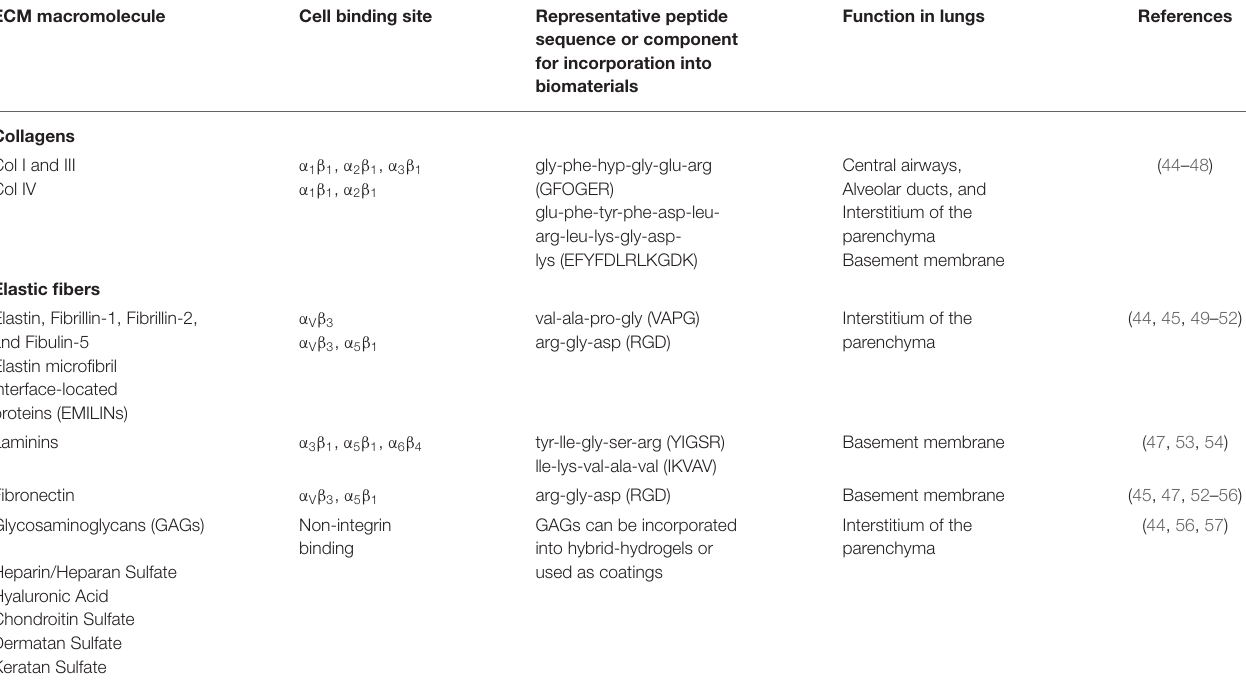
TABLE 2 | Introduction to common ECM components found in the lung, cell binding sites, and common practices for incorporation into